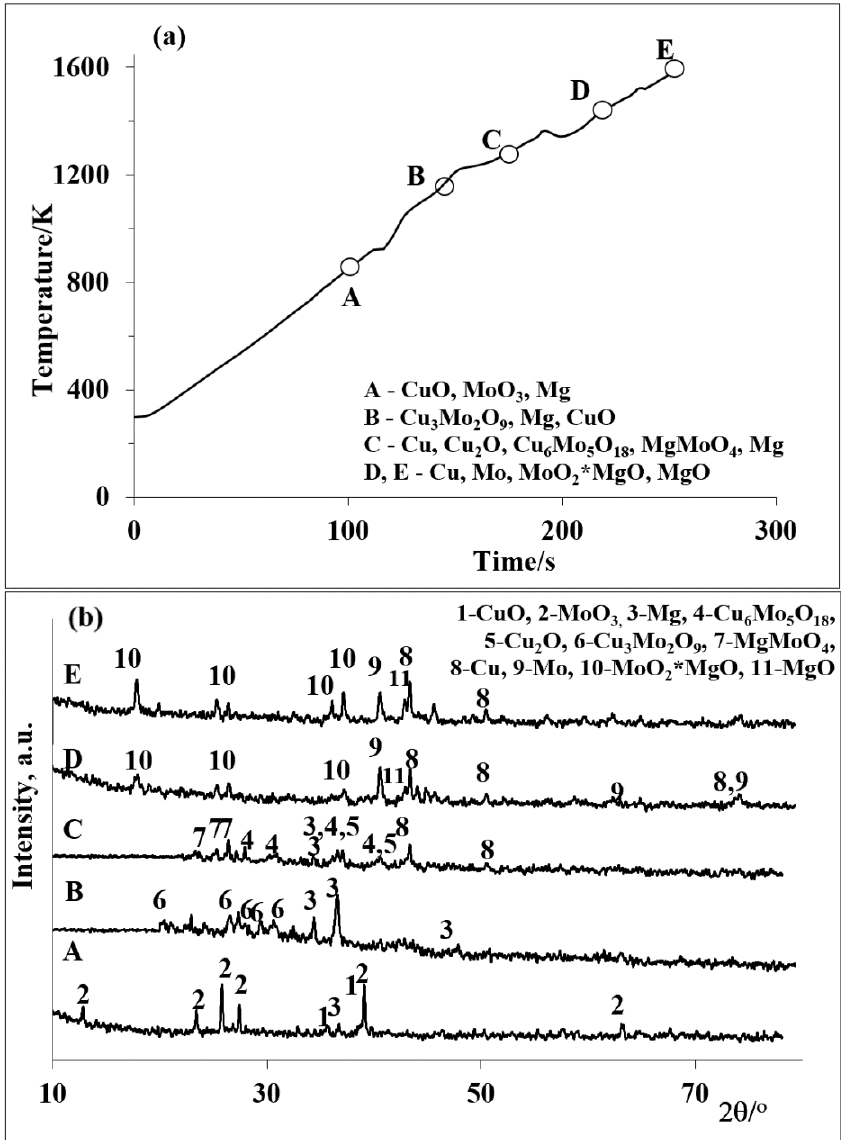
Figure 8. Heating thermogram of the CuO + MoO 3 + 4Mg mixture ( a ) and XRD analysis results ( b ) of the quenched samples at different characteristic temperatures, A—T = 923, B—1143, C—1273, D—1373, E—1473 K, V h = 300 K min − 1 .